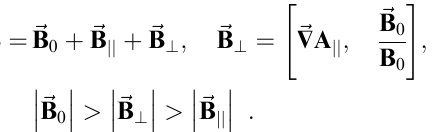
Fig. 4. Wave spectra of the time series constructed by joining plasma and magnetic pressure data corresponding to local dissimilarities found in October 1995 data